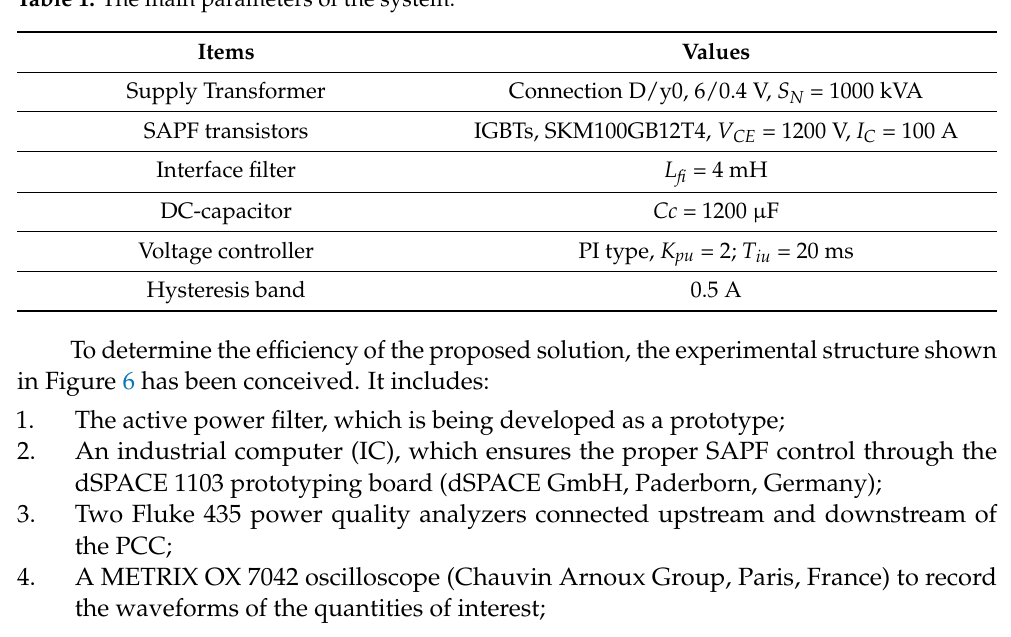
Table 1. The main parameters of the system.